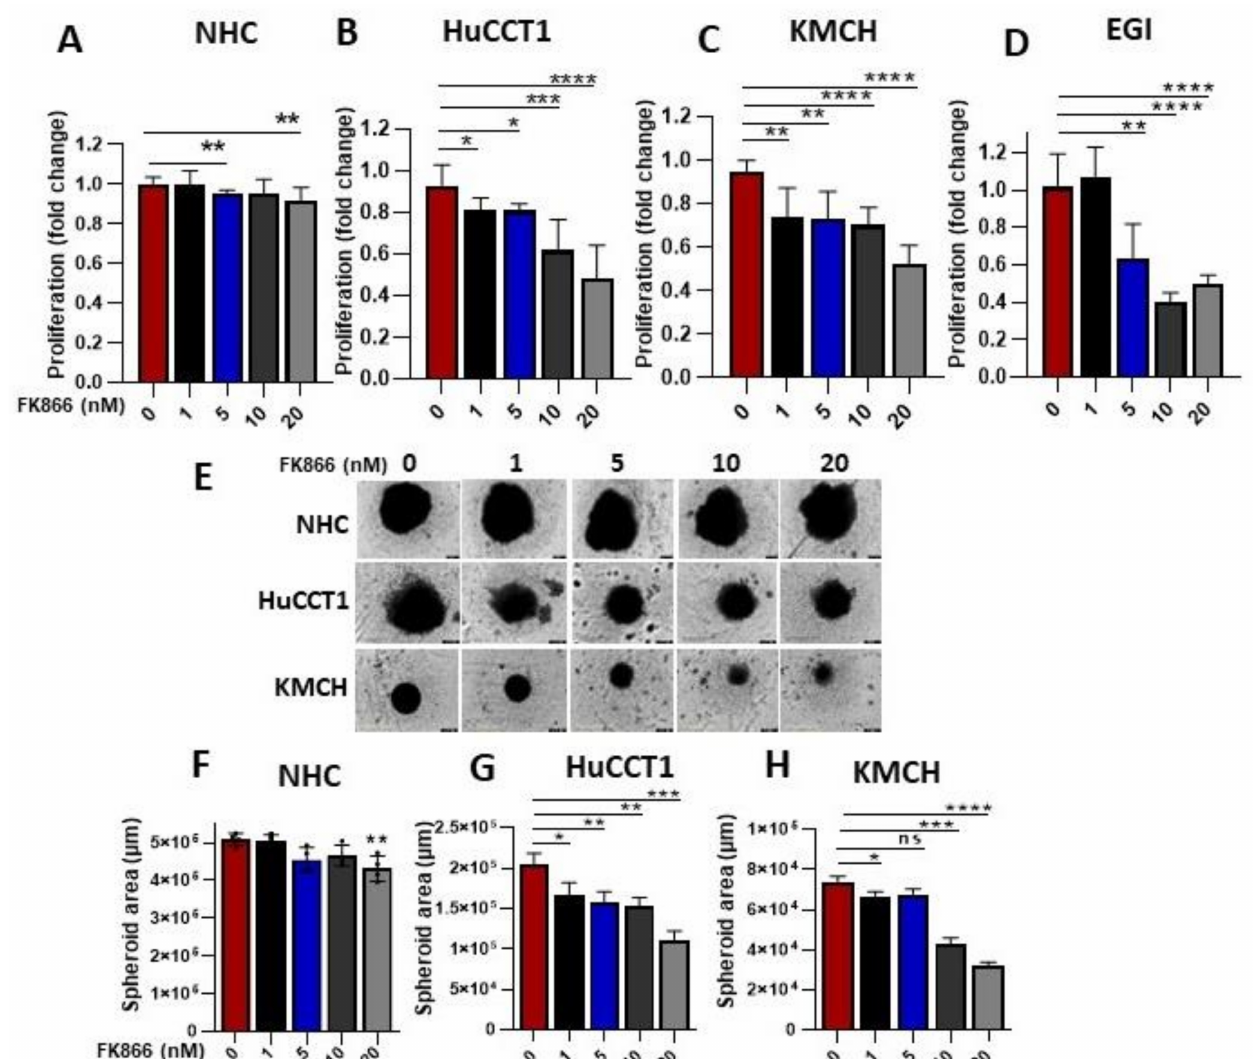
Figure 2. NAMPT regulates CCA cell growth. ( A ) FK866 (1–20 nM) was treated in NHC cells, and an MTS cell growth assay was performed. ( B ) HuCCT1 cells were treated with FK866 (1–20 nM) and cell growth assay was performed. ( C ) MTS assay was conducted in KMCH cells after FK866 treatment at different concentrations (1–20 nM). ( D ) Cell growth analysis was performed in EGI cells followed by the FK866 treatments. ( E ) Spheroid assay was performed in NHC, HUCCT1, and KMCH cell lines in presence of FK866 (0–20 nM). Images were taken in IncuCyte. ( F – H ) , Spheroid area was